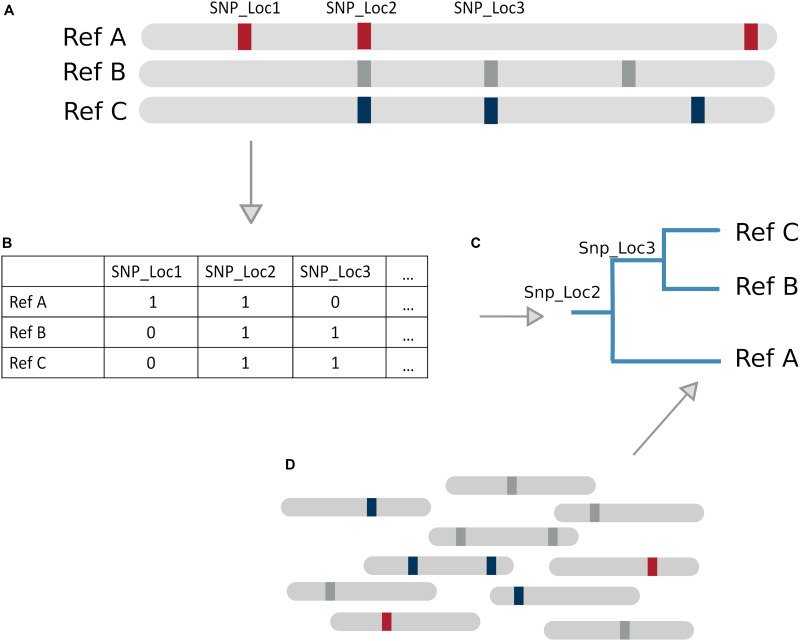
Tree Based Method Overview. (A) Example database of genomes with SNPs present as markers. (B) Representation of genome database, where 1 denotes a SNP and 0 absence of a SNP (C) SNP tree constructed based on SNPs from the database. (D) SNPs present in new reads can be matched against the tree to infer likely reference genome of origin by identifying sequences of successfully matching nodes (a path).